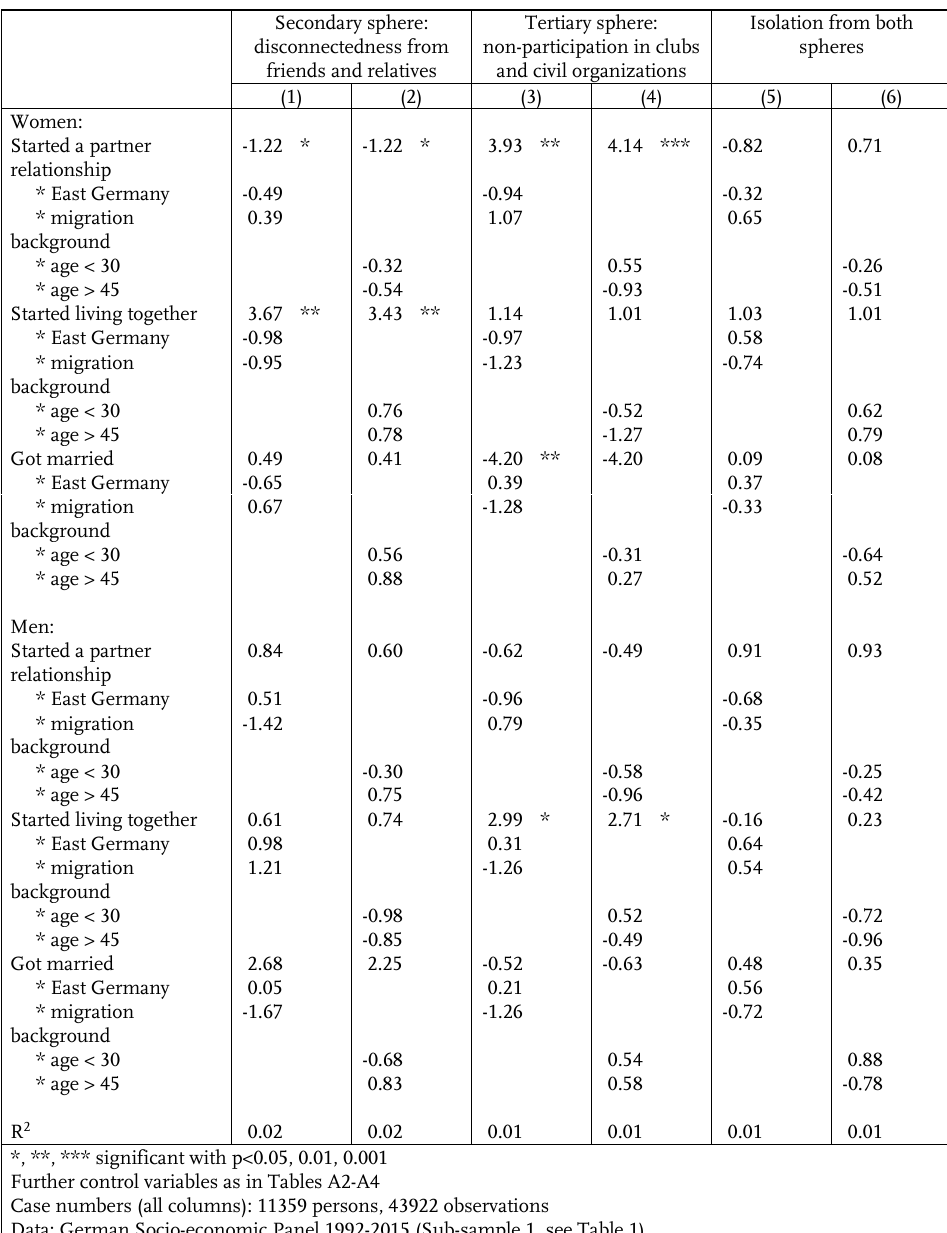
Table A.5 : Moderation of the effects of partner relationships by region, migration background, and age (linear-probability models with fixed effects, percentage points) Secondary sphere: Tertiary sphere: Isolation from both disconnectedness from non-participation in clubs friends and relatives and civil organizations